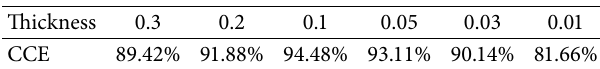
Figure 11: Model of multisegment exponential doping structure of electron multiplication Table 1: Effect of the thickness of the heavy index doping layer on the charge collection efficiency.